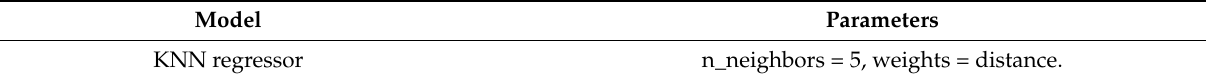
Table 6. Parameters used for KNN regressor model.